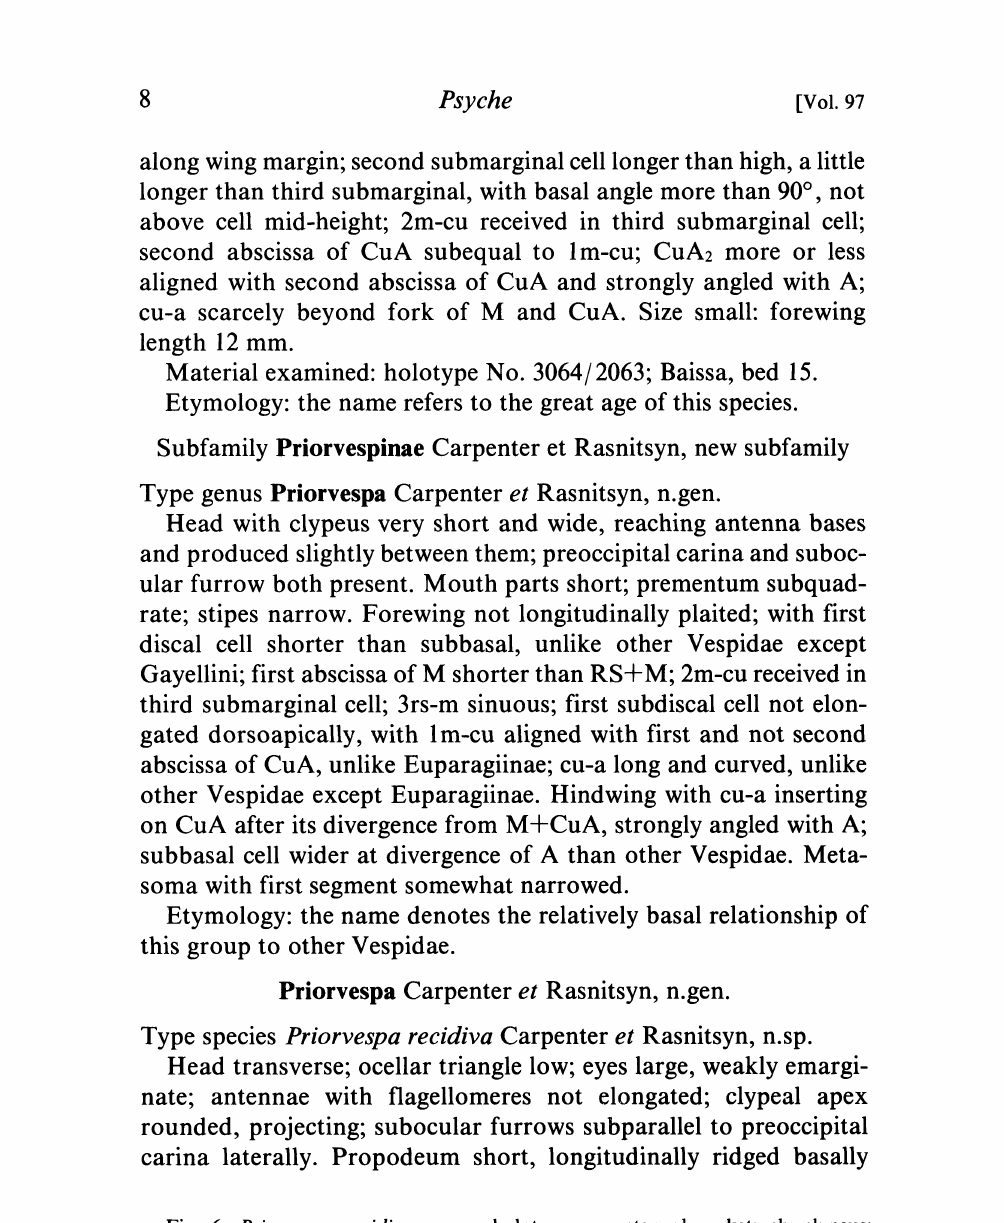
Fig. 6. Priorvespa recidiva n. sp., holotype, as-antennal socket; cly-clypeus;